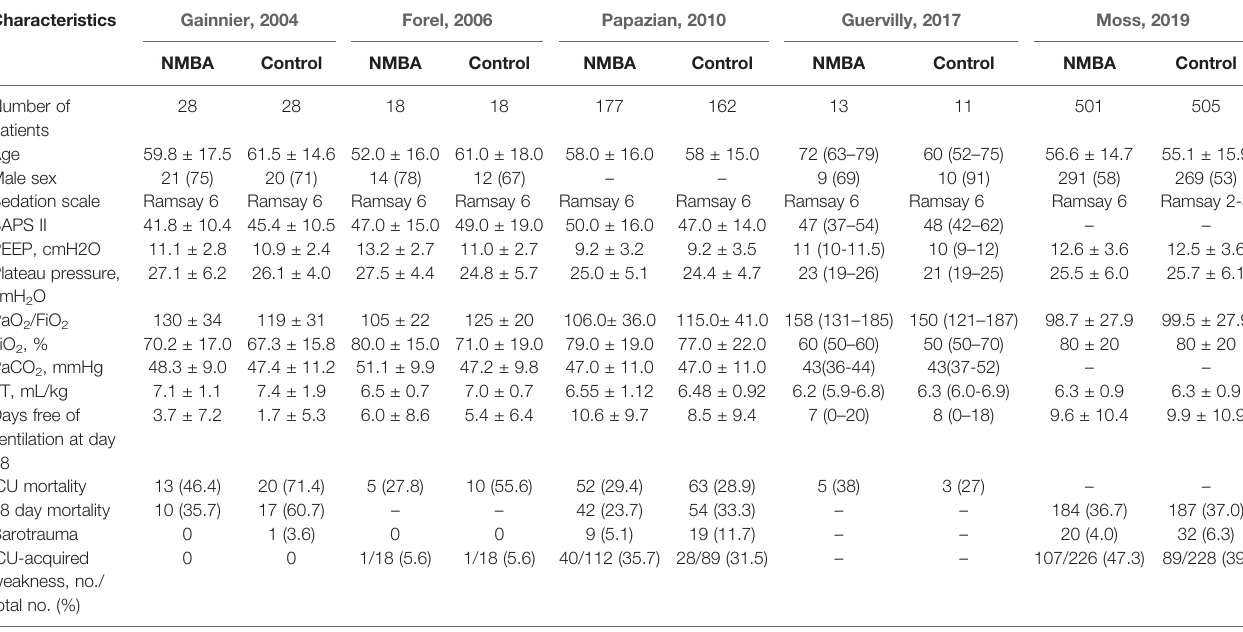
TABLE 2 | Characteristics of NMBA and control group in included studies.